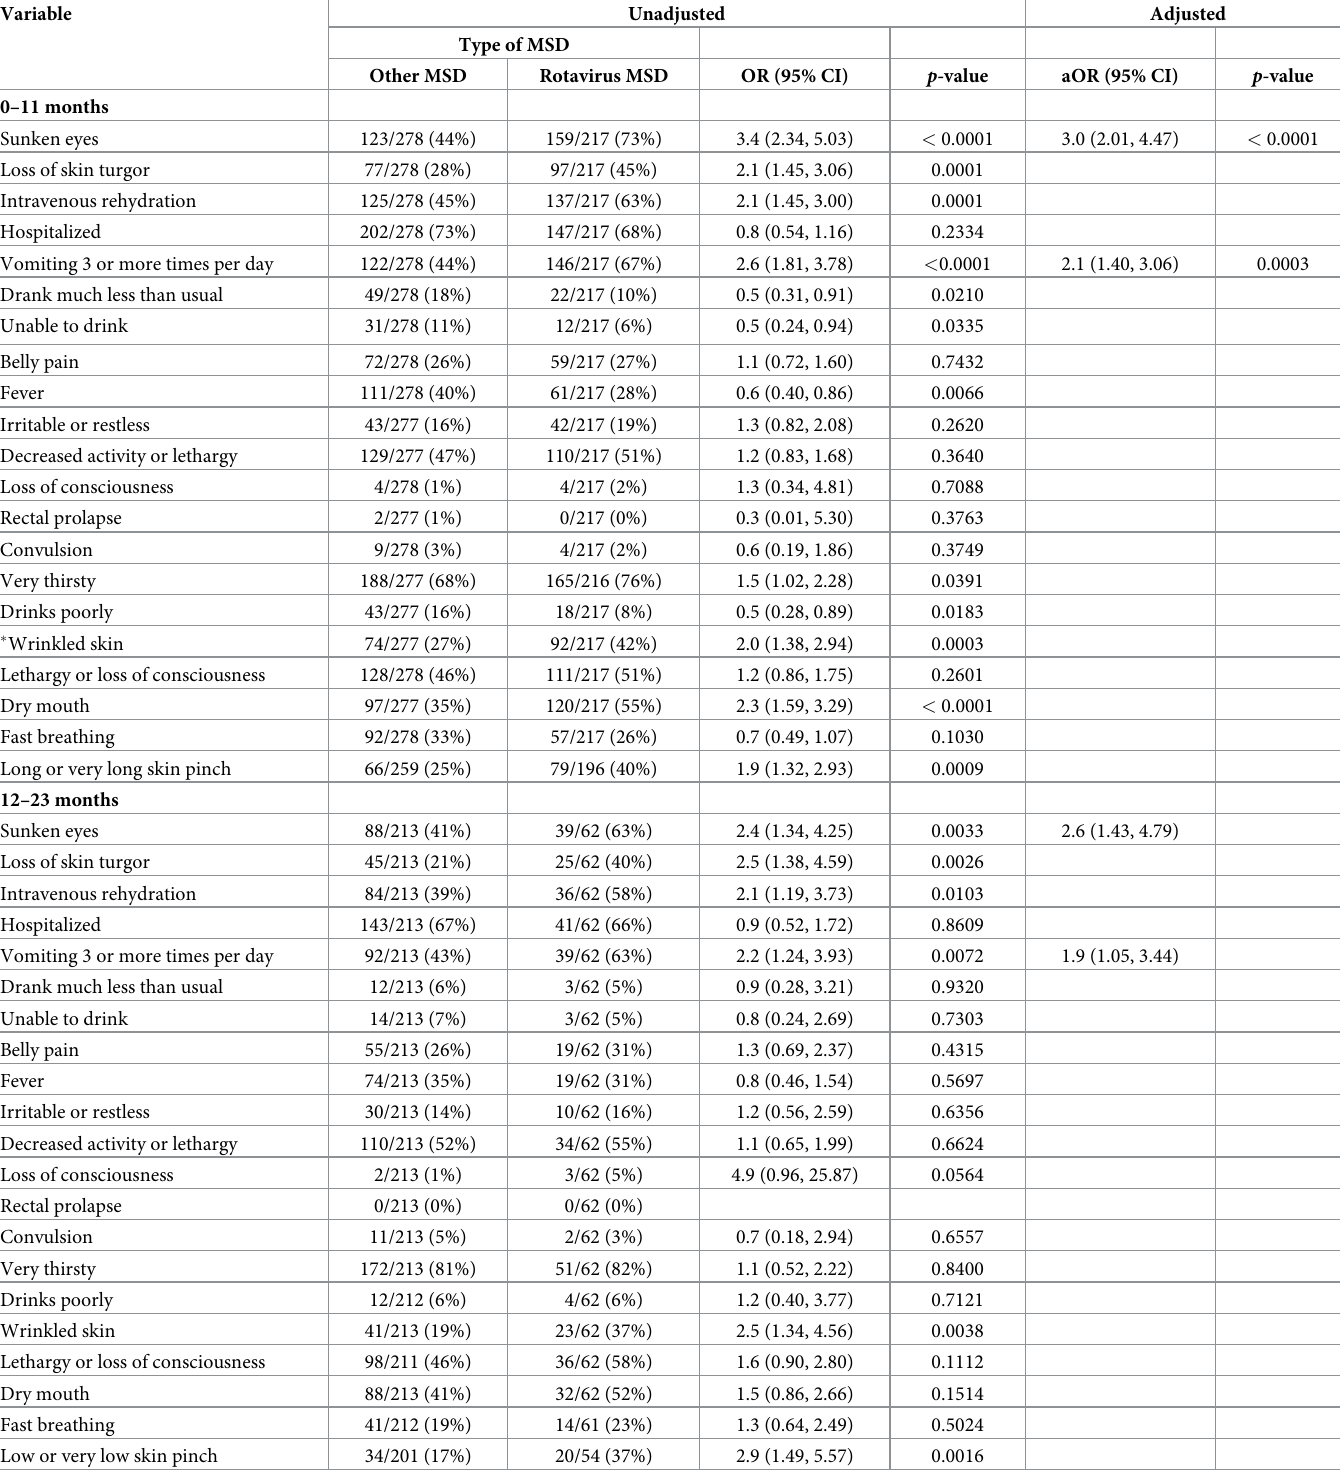
Table 4. Signs and symptoms of children 0–59 months of age with moderate-to-severe diarrhea associated with confirmed rotavirus. (Crude and multivariate